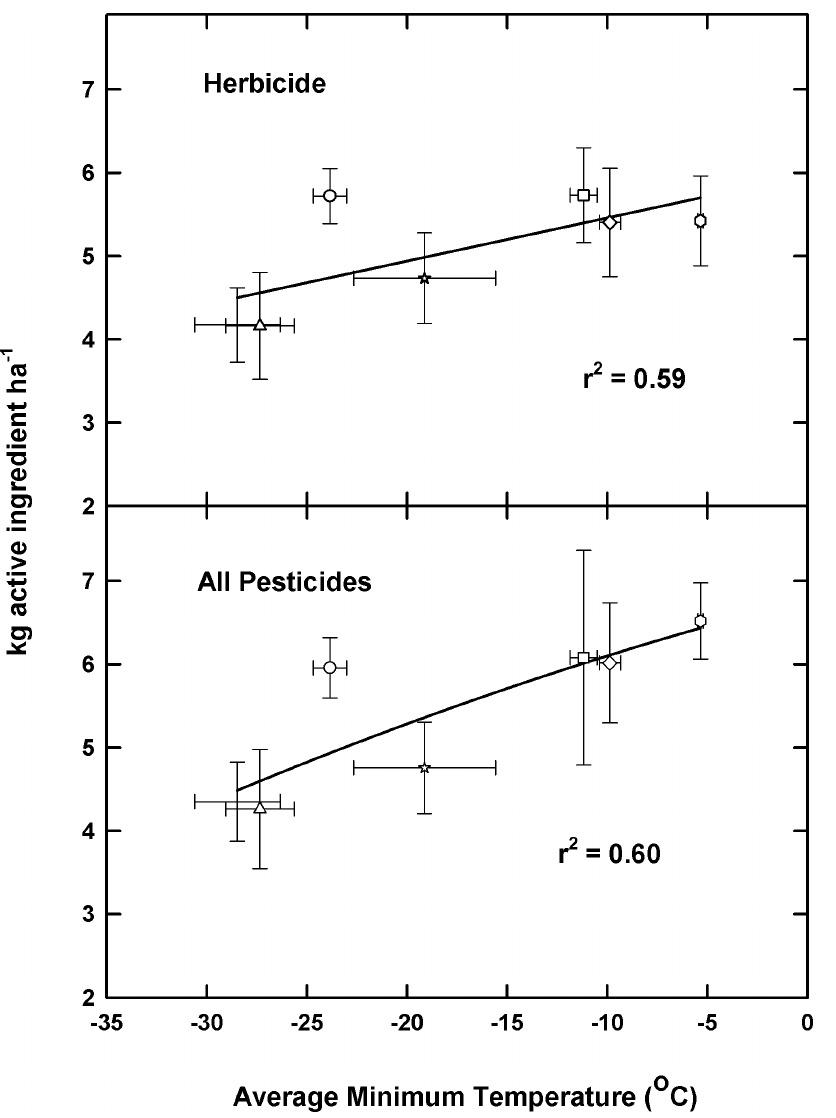
Figure 2. Symbols and regression determined as for figure 1, but for herbicide use and total pesticide (insecticide, fungicide and herbicide) usage for